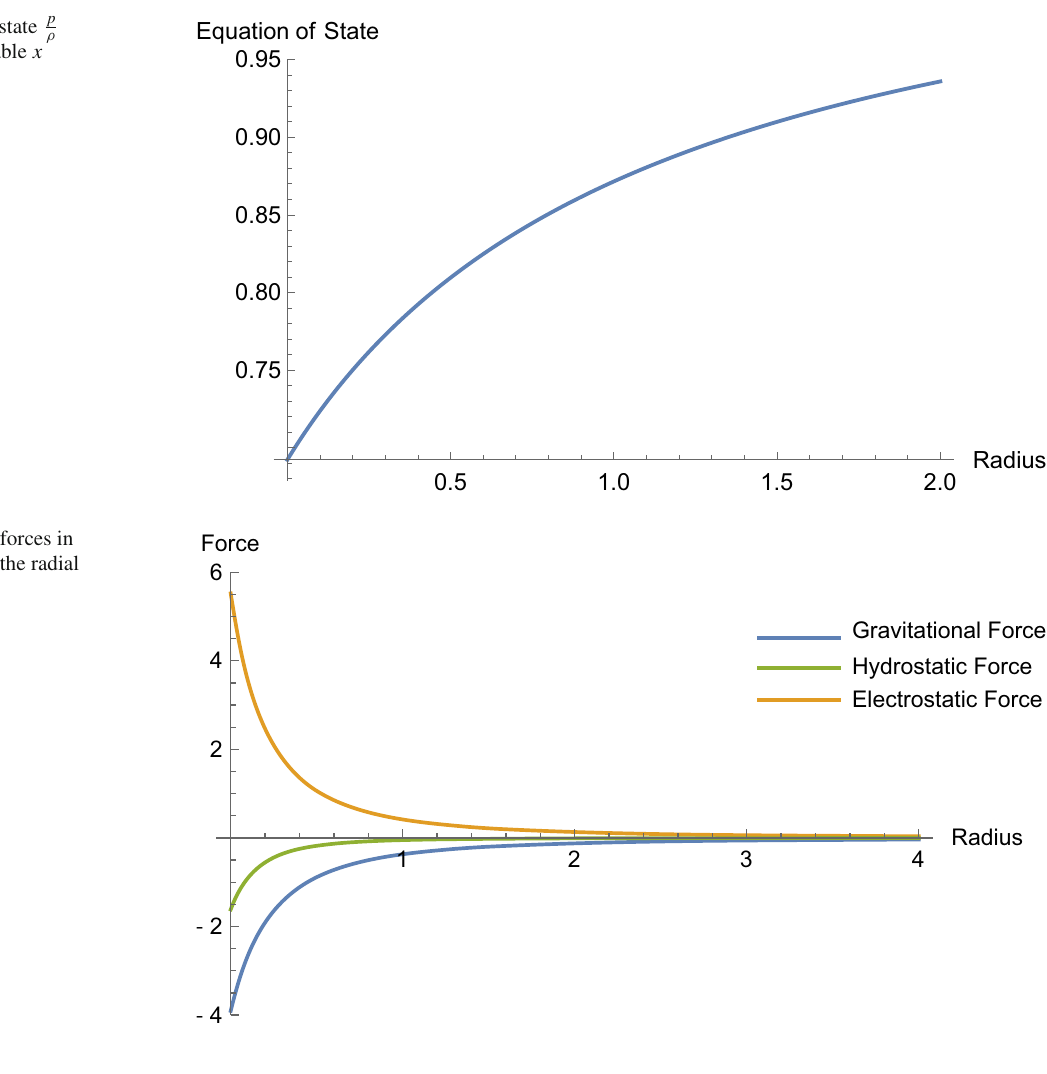
Table 1 Viable metric potentials for embedding class 1